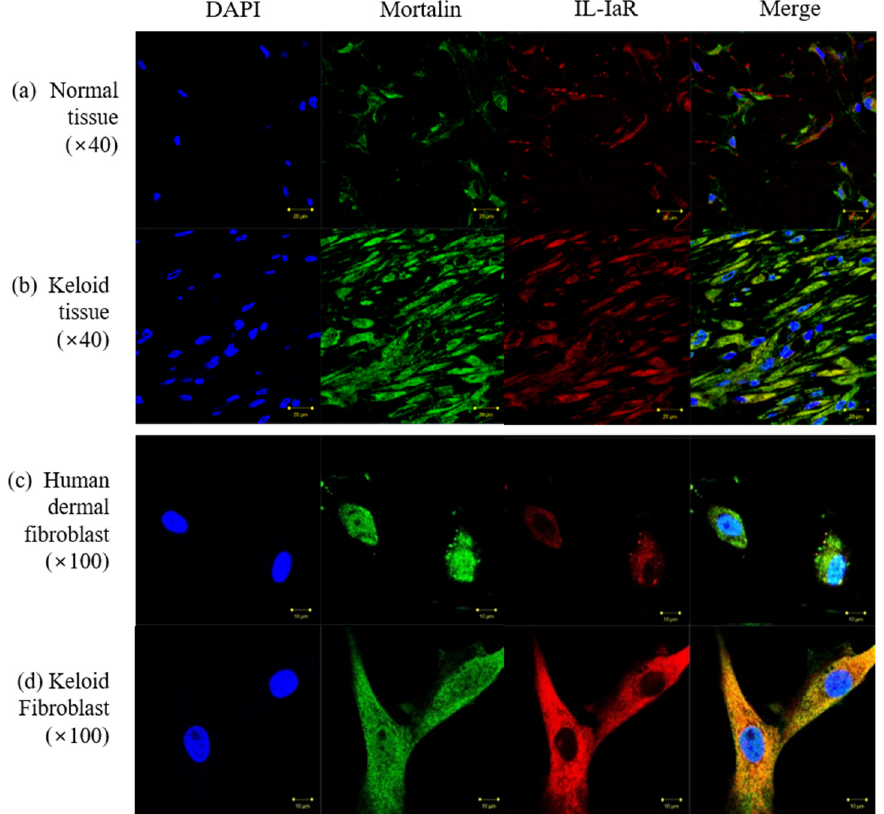
Figure 3. Evaluation of mortalin expression using immunofluorescence (mortalin, green; nucleus, blue; IL-1 α receptor, red) ( a , b ) Mortalin and IL-1 α receptor were overexpressed in keloid tissues compared to their expression in the extra-lesional normal tissues (40×); ( c , d ) Mortalin and IL-1 α receptor were expressed in the perinuclear area on the HDFs; however, overexpression of mortalin and IL-1 α receptor in the cytosol was observed on the KFs, and cytoplasmic accumulation of IL-1 α receptor was observed in the KFs (100×). HDFs and KFs were double labeled with mortalin and IL-1aR; Scale bars: 10 µm for tissue and 20 µm for fibroblast.